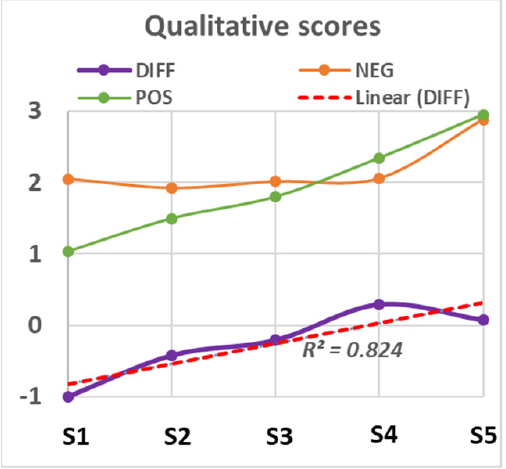
Figure 14. Evaluation summary. DIFF, difference score; POS, positive; NEG, negative.